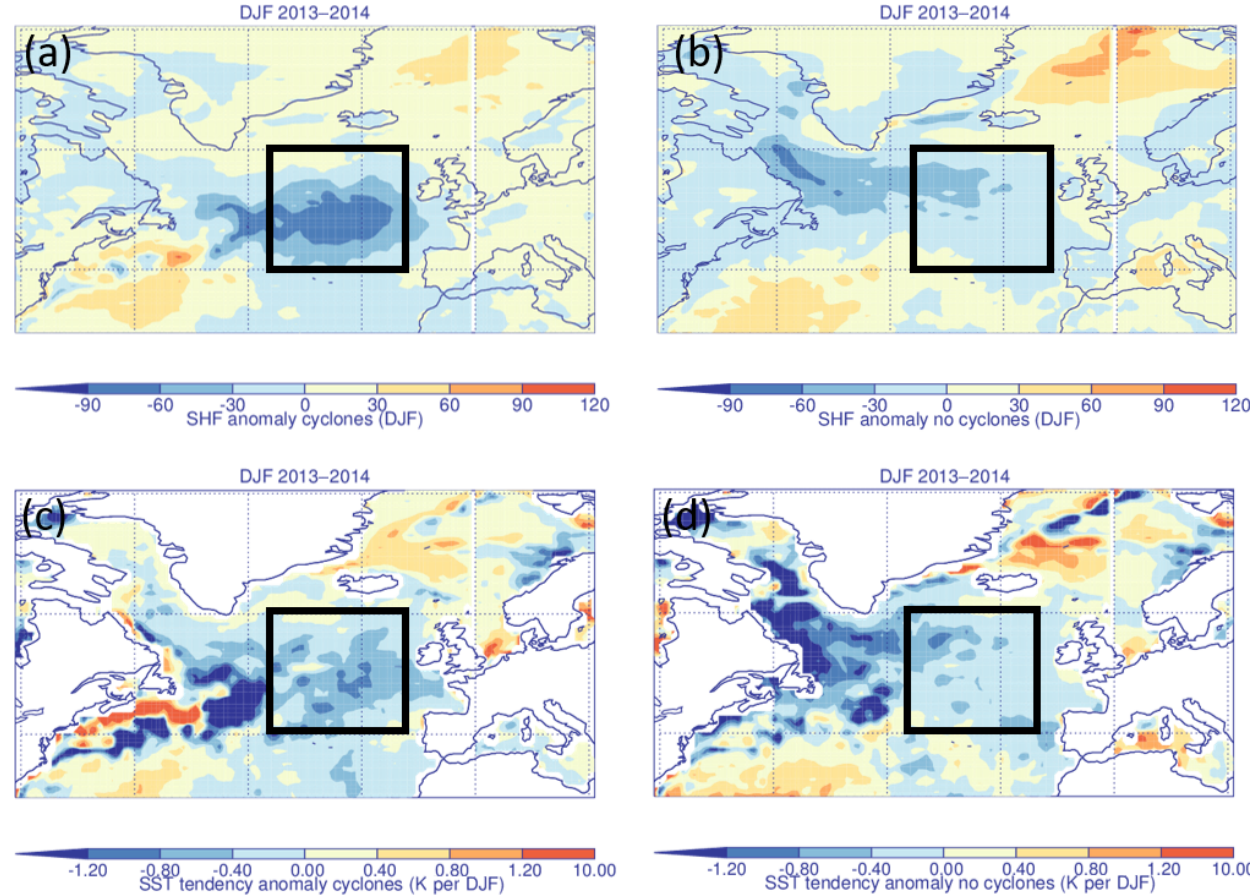
Figure 12. 2013–2014 anomalous Q N associated with (a) both cyclones and the environmental flow and (b) the environmental flow. 2013– 2014 anomalous (cid:49) SST due to anomalous Q N , MLD and entrainment associated with (c) both cyclones and the environmental flow and (d) the environmental